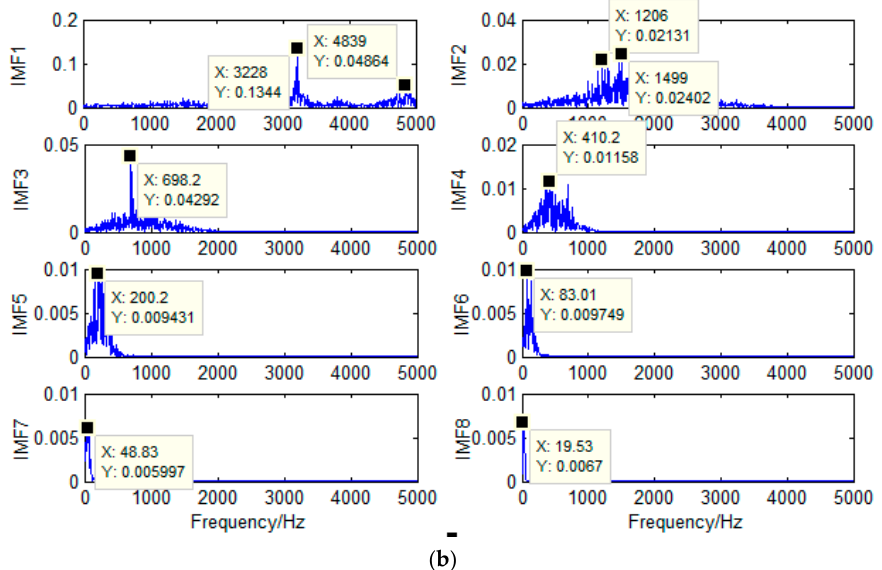
Figure 25. Spectrogram of an IRF + BF and its IMF Components. ( a ) Spectrogram of an IRF + BF signal sample; ( b ) Spectrogram of the eight-order IMFs.